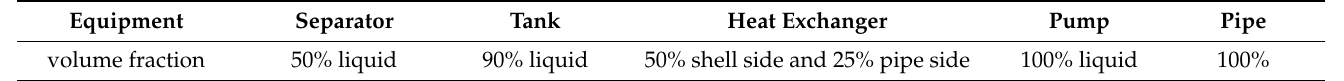
Table 3. Assumptions for calculating the liquid inventory in the